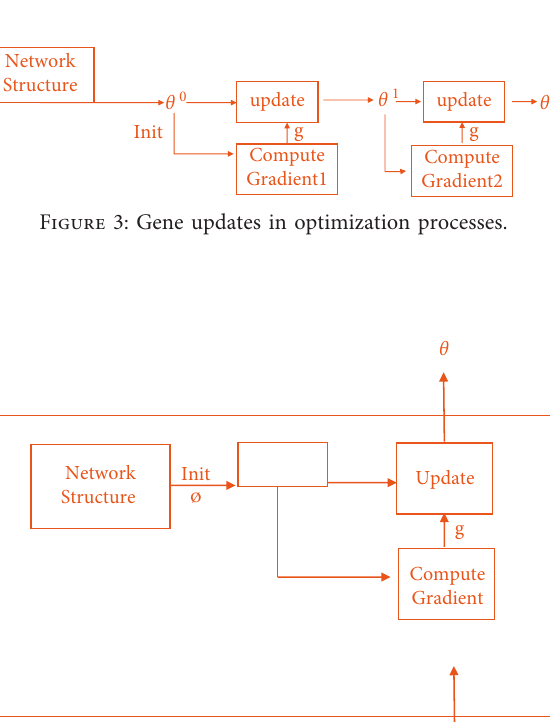
Figure 2: The relationship between ∅